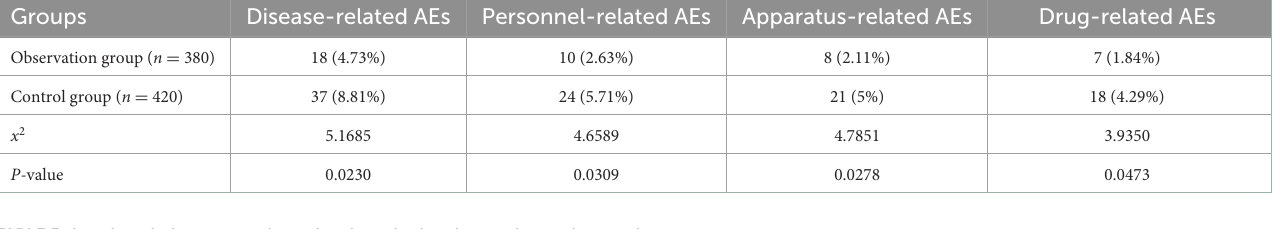
TABLE 5 Intrahospital transport time of patients in the observation and control groups. Groups